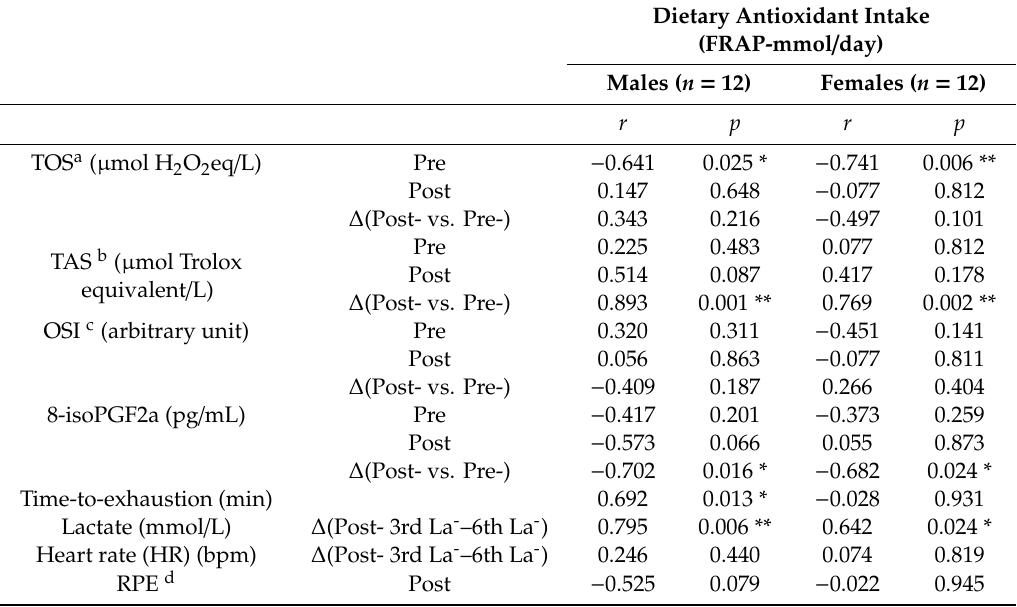
Table 3. Correlations of pre- and post- exercise plasma biomarkers related to oxidative stress with dietary antioxidant intake, adjusted for years of training, and average